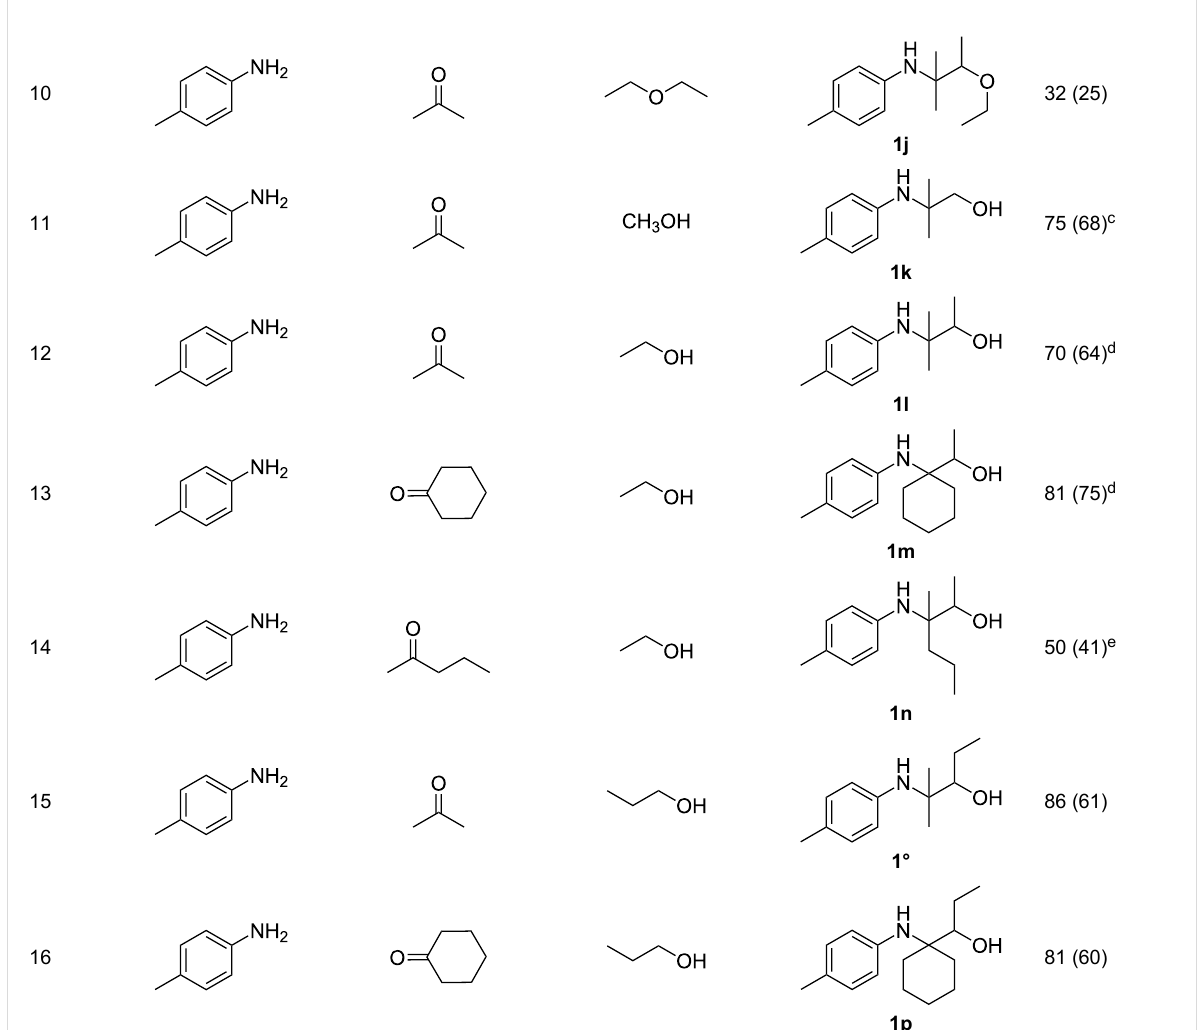
Table 2: Aminoalkylation of ethers and alcohols.